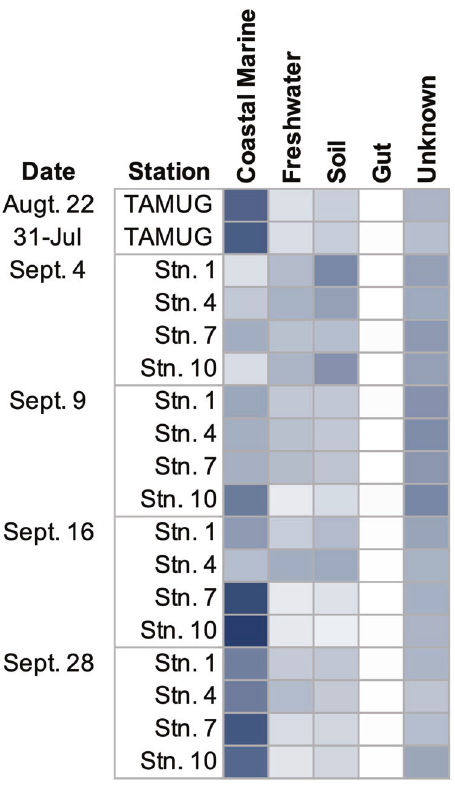
Fig. 5 The estimated proportion of each source environment contributing to each metagenome as determined using mSource- tracker. The sources used in mSourcetracker include coastal marine metagenomes from Ocean Sampling Day (2014), freshwater metagenomes from the Solimões river, soil metagenomes from Australia, human gut metagenomes. Unknown stands for sequences of undetermined